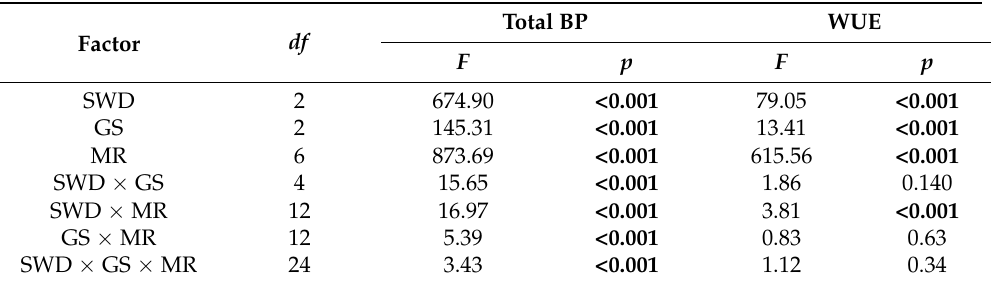
Table 1. Results of three-way ANOVA testing effects of soil water decreasing (SWD), growth stage (GS), mixture ratio (MR), and their interactions on total biomass production (BP) and water use efficiency (WUE) of the mixtures.